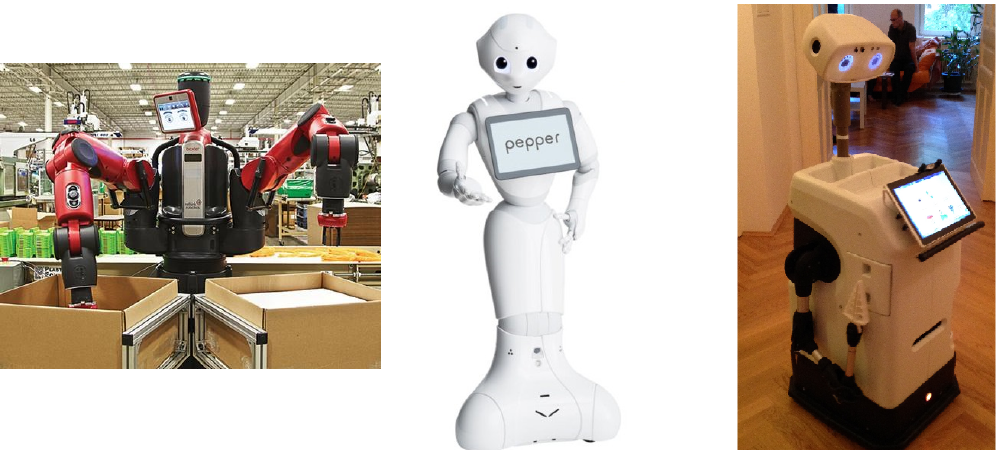
Figure 9. The three robot platforms used to evaluate the performance of our approach: the Baxter robot [33] (left), the Pepper robot [34] (center) and the Hobbit robot [35]